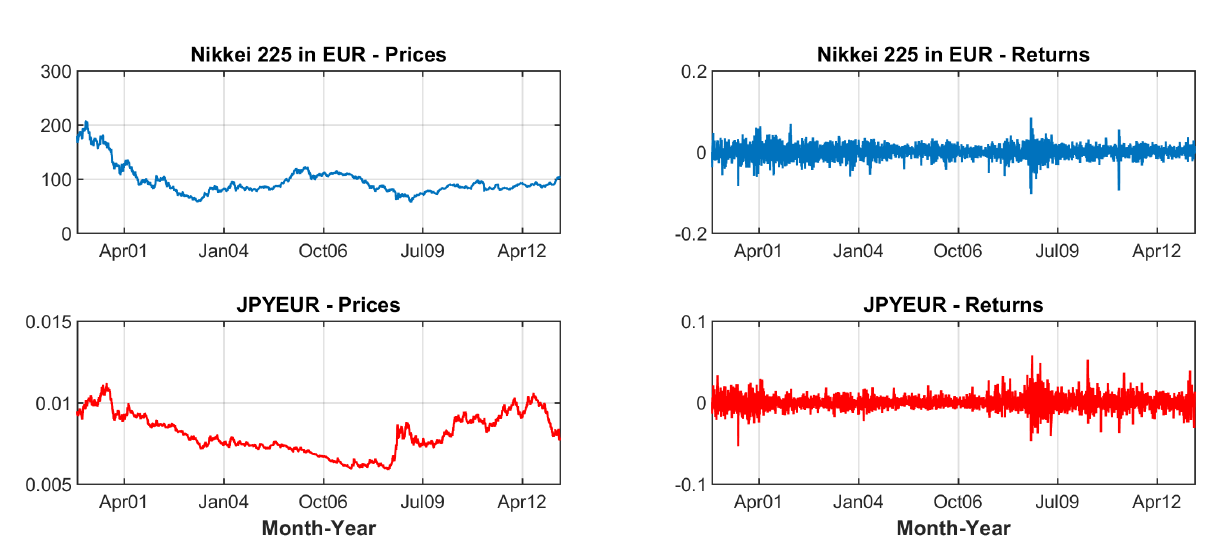
Figure 1. Top: Nikkei 225 in EUR ( left ) and its log returns ( right ). Bottom: JPYEUR levels ( left ) and log returns ( right ). Sample period 4 January 2000 to 15 April 2013. Table 1. Parameter estimates and bootstrapped 95% confidence intervals (in brackets) using 1000 simulated paths of length 3206 (inline with our historical return data set). For all time series, both the log-likelihood values and the model-selection criteria AIC and BIC strongly favor the NTS over the Black–Scholes model. Black–Scholes